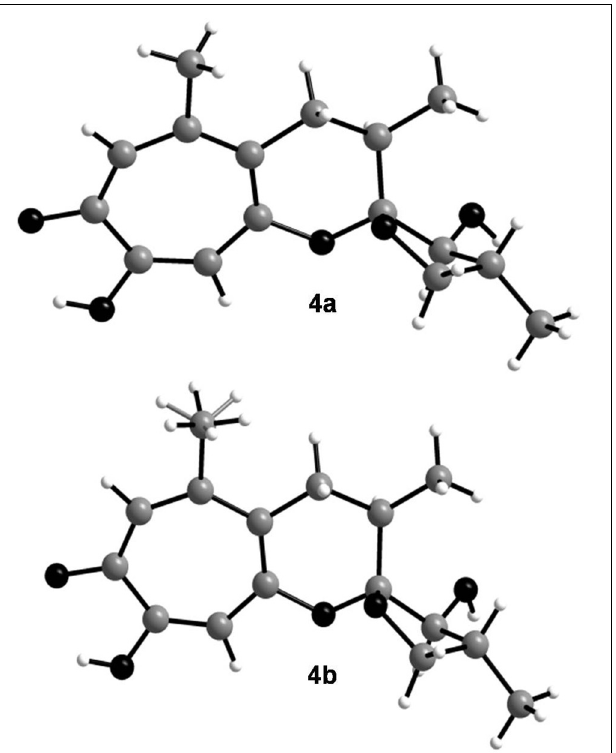
FIGURE 3 | Crystal structures of the two crystallographically distinct molecules of malettinin E (4a and 4b). The H atoms of one of the methyl groups in 4b are disordered.